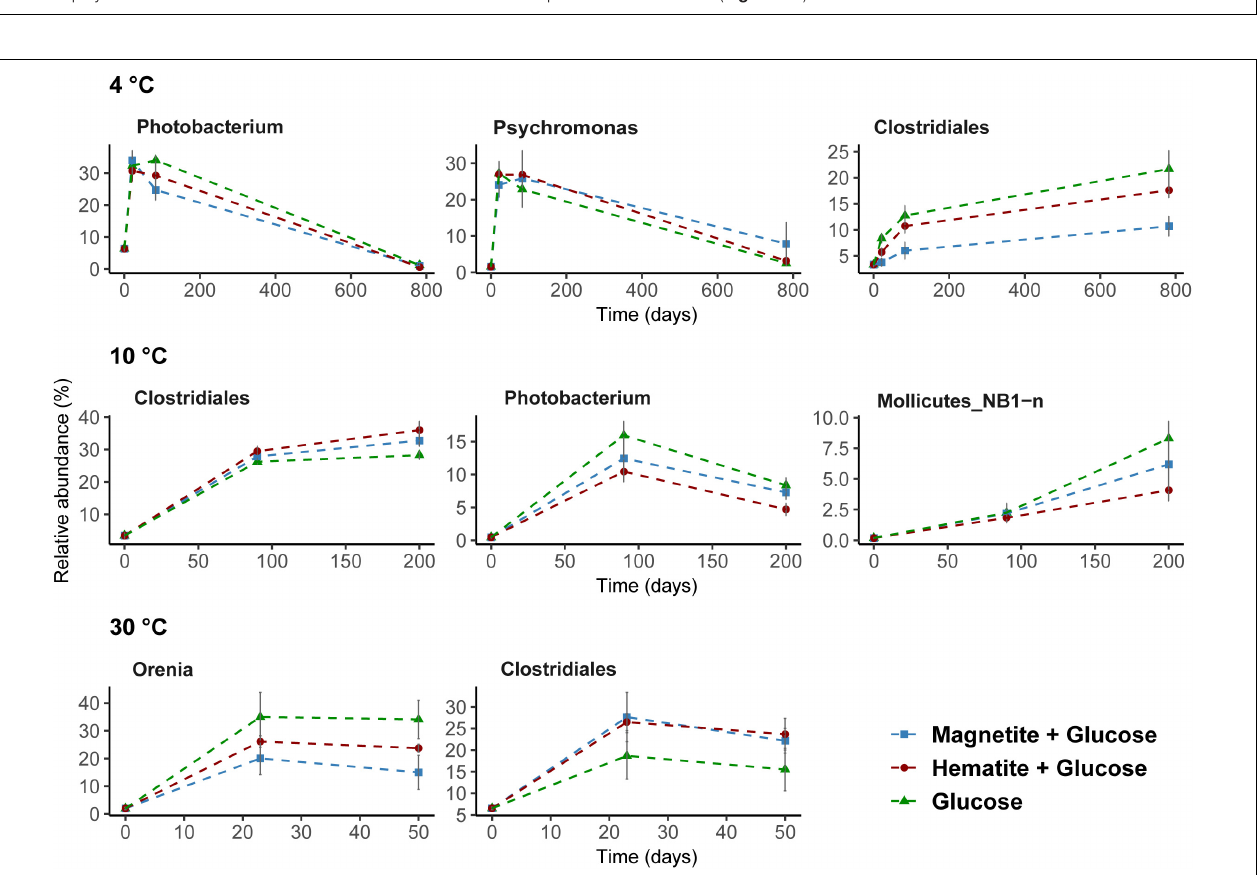
FIGURE 4 | Dominant bacteria communities enriched over time at 4 ◦ C, 10 ◦ C, and 30 ◦ C determined by 16S rRNA gene analysis. A threshold of relative abundance increase of 5% was used to determine key taxa (from order to genus level) compared to controls. Percentages show relative abundance of individual genus or order. Data presented here are reflecting the main bacteria taxa that were stimulated by glucose addition to slurry incubations.